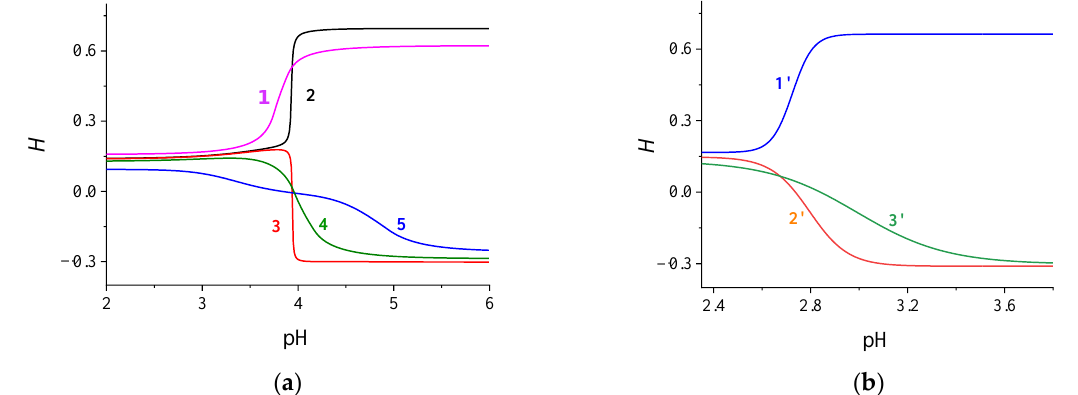
Figure 4. Simulated H profiles vs. pH, parametric in log C I , in the absence ( a ) and presence of surfactant ( b ). ( a ) 𝑙𝑜𝑔𝐶 𝐼 ∙ 𝑝 = − 5.51 (purple, 1), − 4.46 (black, 2), − 4.43 (red, 3), − 4.25 (green, 4), − 3.80 (blue, 5). ( b ) 𝑙𝑜𝑔𝐶 𝐼 ∙ 𝑝 = −3.90 (blue, 1’), −3.71 (red, 2’), −3.50 (green, 3’).